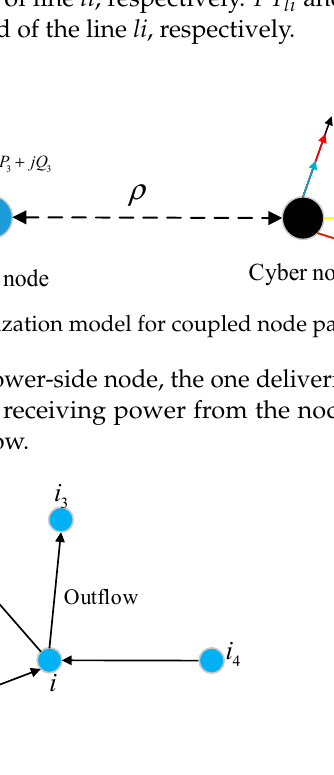
Figure 3. Parent and child nodes of a power node.